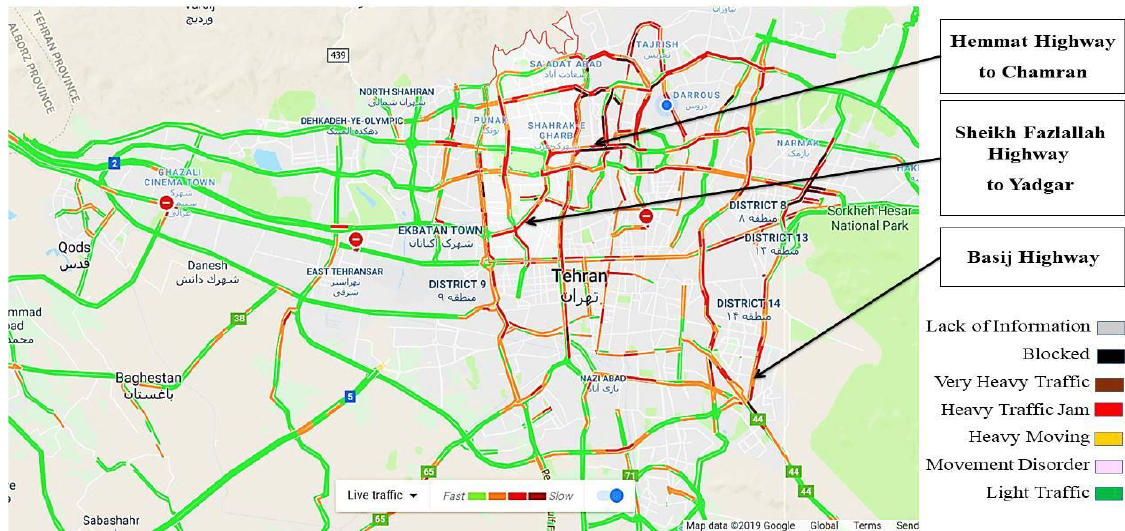
Fig. 1. Online map of Tehran’s Traffic, Fall 2018 (Source: